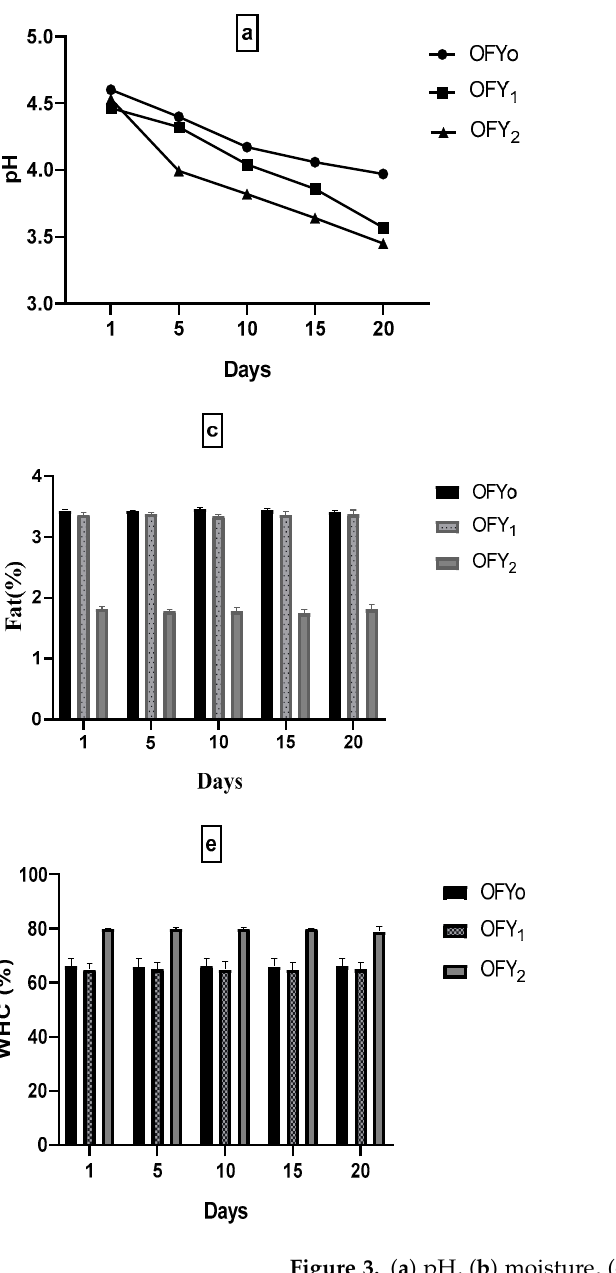
Figure 3. ( a ) pH, ( b ) moisture, ( c ) fat, ( d ) ash, ( e ) water holding capacity (WHC), and ( f ) protein contents of different yogurt treatments. Results are expressed as mean with standard deviation bar.